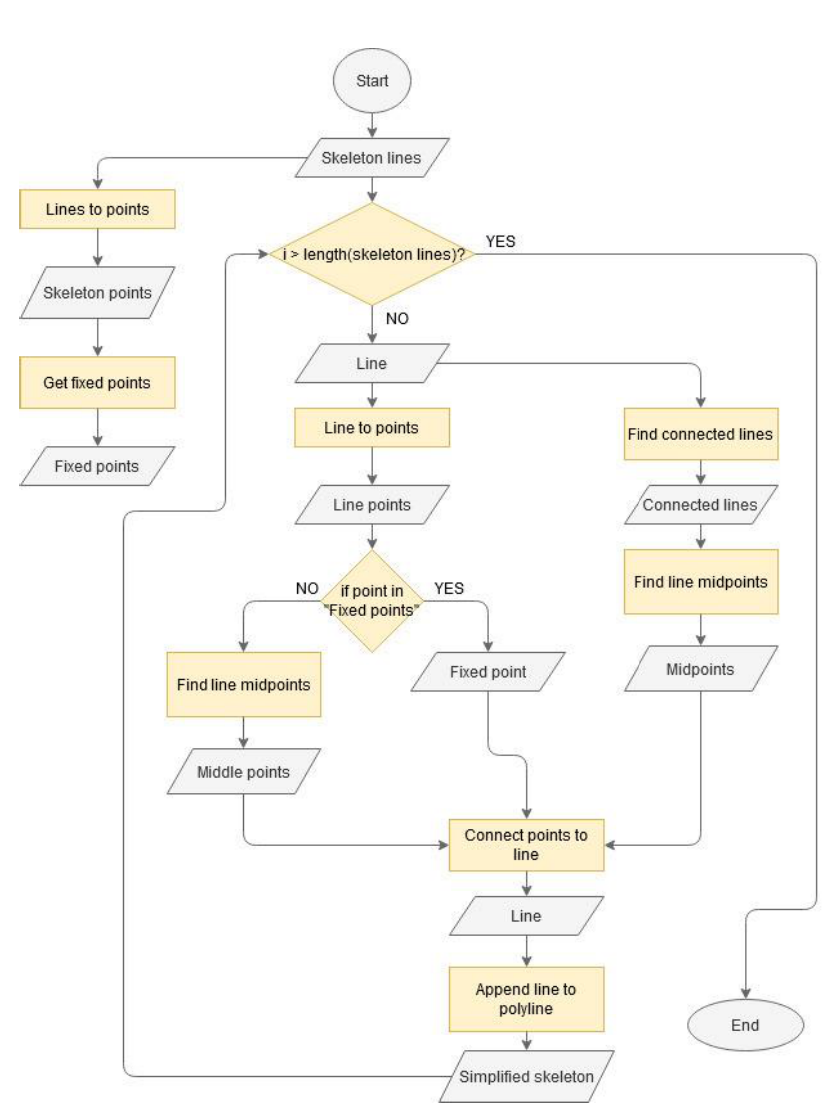
Figure 14. A flowchart of the algorithm for skeleton generalization.